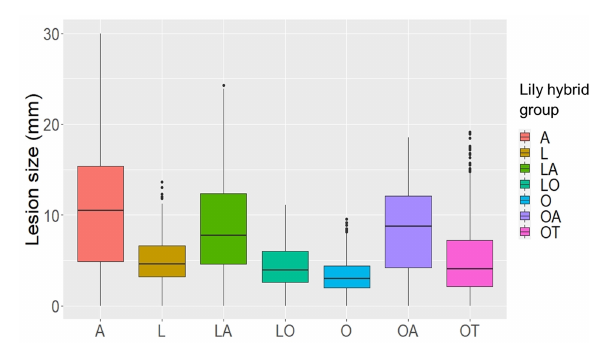
FIGURE 1 | Lesion diameters at 4 dpi upon inoculation of 12 different B. elliptica isolates on leaves of seven different lily hybrid groups. Each box represents all compiled lesion diameters (in mm) for a given lily hybrid group in all four repetitions of the disease